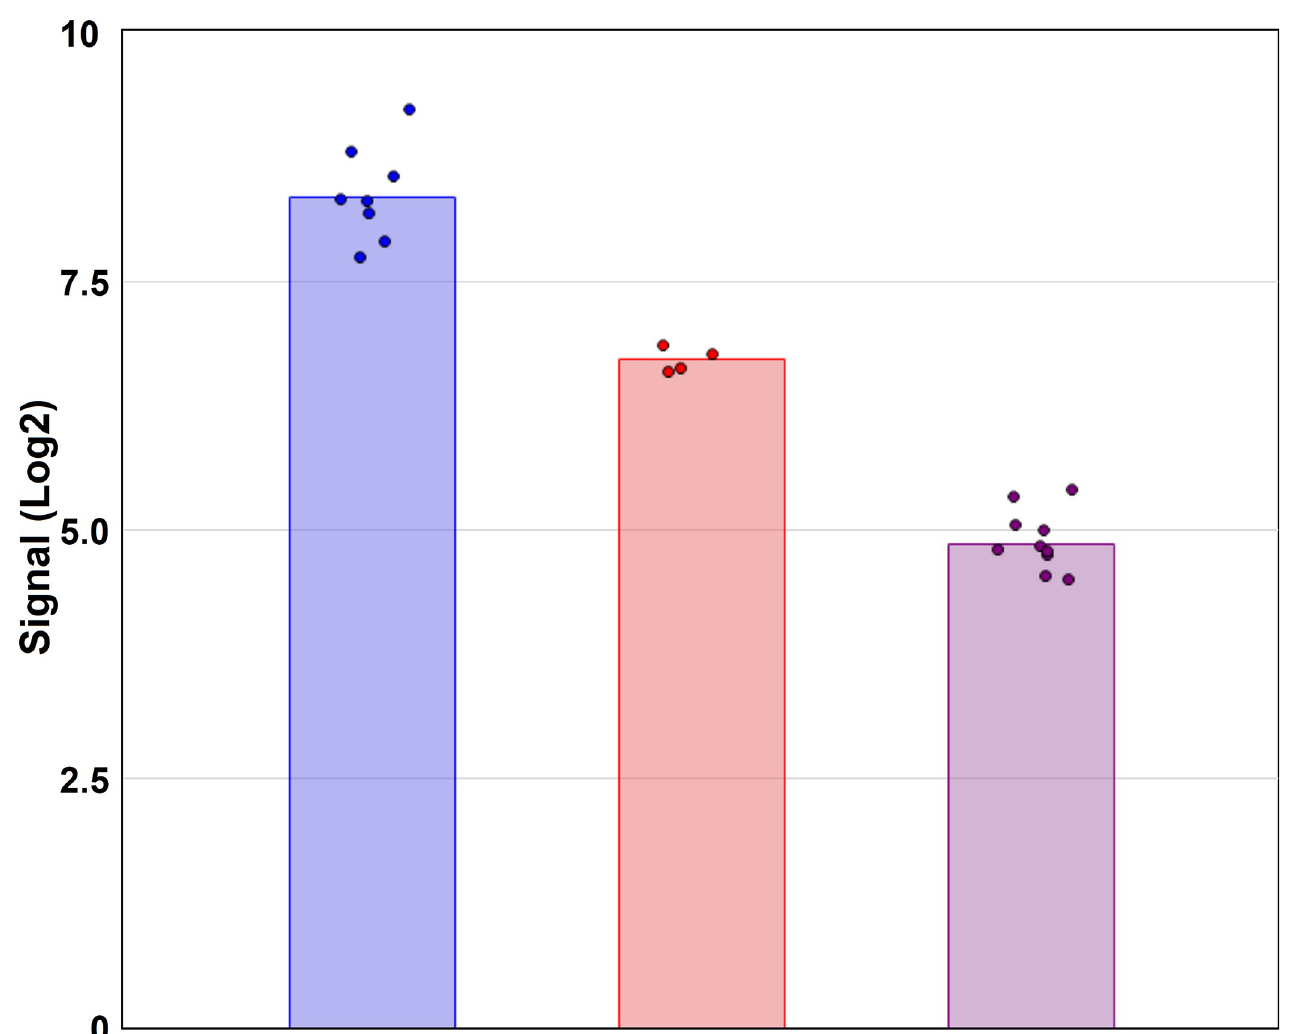
Fig 2. Categorization of GSE77259 and GSE100534 samples according to DCC expression values. DEGs in the DCC expression groups were compiled from DCC low vs . DCC high expression groups. Blue bars, DCC high expression samples; red bars, DCC medium expression samples; and purple bars, DCC low expression samples. Dots indicate expression values of individual samples. Significance between DCC low and DCC high expression groups is based on an FDR-adjusted p -value <